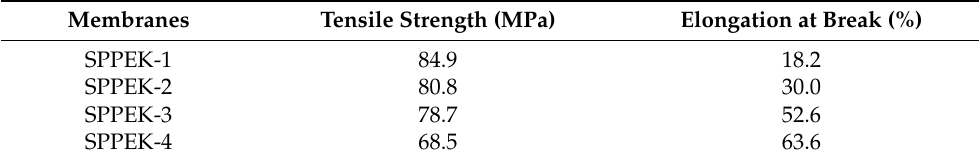
Figure 7. Cross-section microstructure of membranes, ( a ) SPPEK-1, ( b ) SPPEK-2, ( c ) SPPEK-3, ( d ) SPPEK-4. Table 2. Mechanical properties of SPPEK membranes.